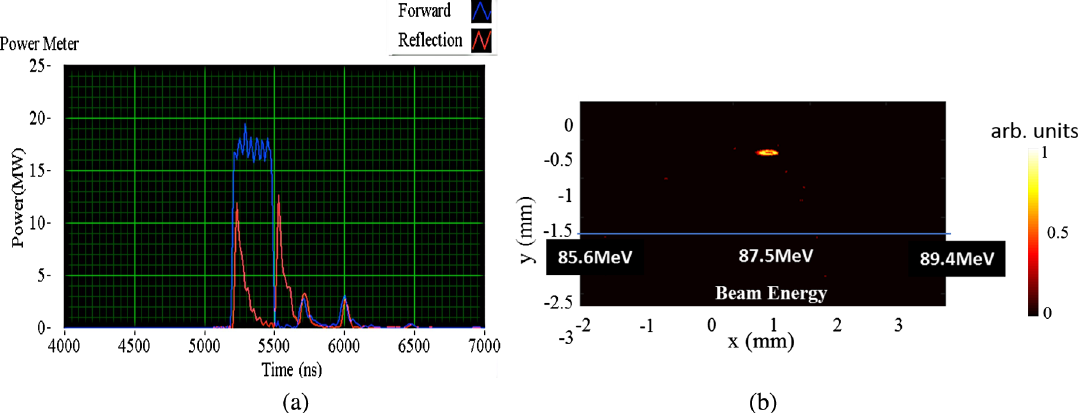
FIG. 10. The energy gain of a synchronized electron-beam entering the structure with an energy of 63.5 MeV. (a) The structure was fed with a square pulse of 300 ns and a power level of 17.5 MWas shown. (b) The energy of the accelerated electron bunch is 87.5 MeV; i.e., energy gain is 24